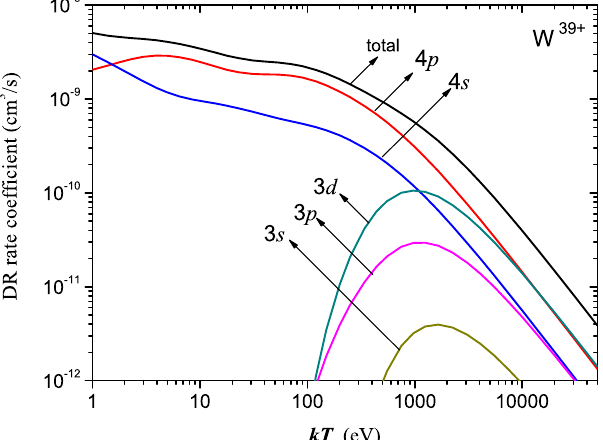
Figure 6. The presently calculated total and partial DR rate coefficients of W 39+ ions as a function of electron temperature kT . This charge state W 39+ is inferred to be dominant e at around 2 keV in modeling International Thermonuclear Experimental Reactor (ITER) plasmas